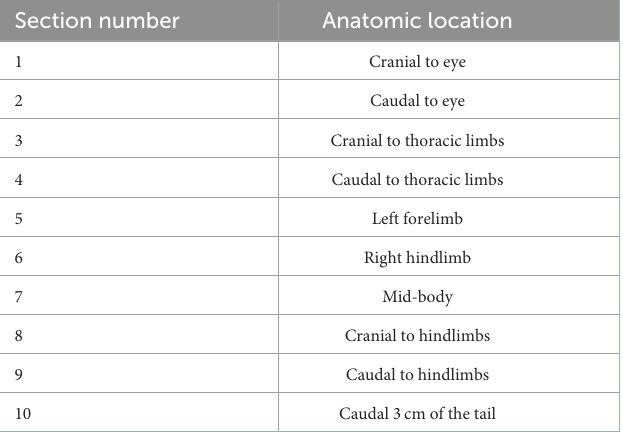
TABLE 1 Anatomic location associated with each of ten standardized sections examined histologically for lesion counts and grading in Batrachochytrium salamandrivorans infected Taricha granulosa